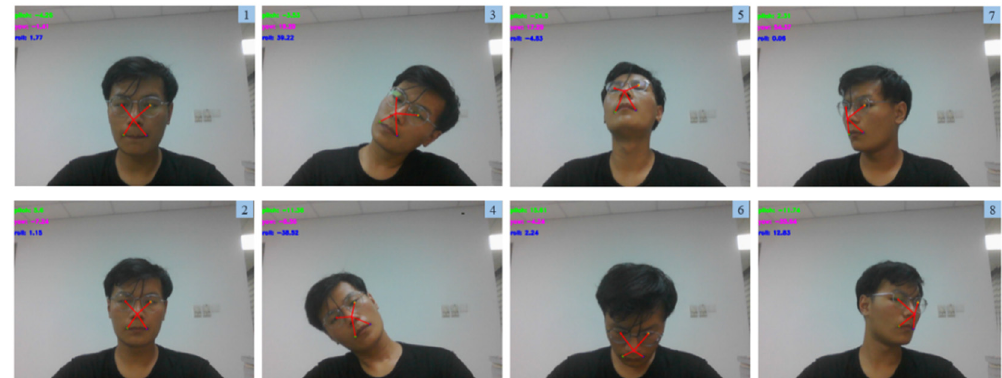
Figure 4. Results of head pose estimation by EPnP in a natural scene. 1 and 2 indicate that the head postures are normal. 3 and 4 indicate abnormal head rolling angles. 5 and 6 indicate abnormal head pitch angles. 7 and 8 indicate abnormal head yaw angles.